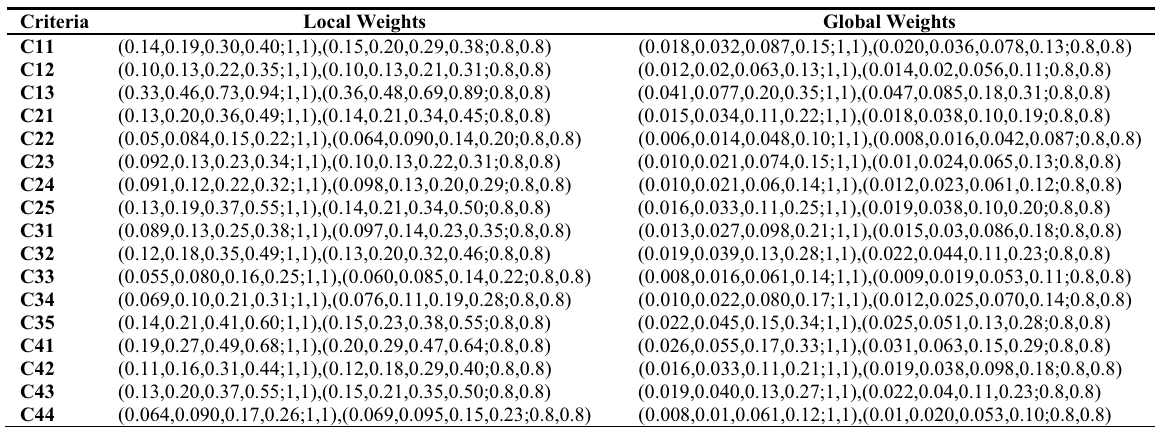
Table 13: Local and global weights of the subcriteria.